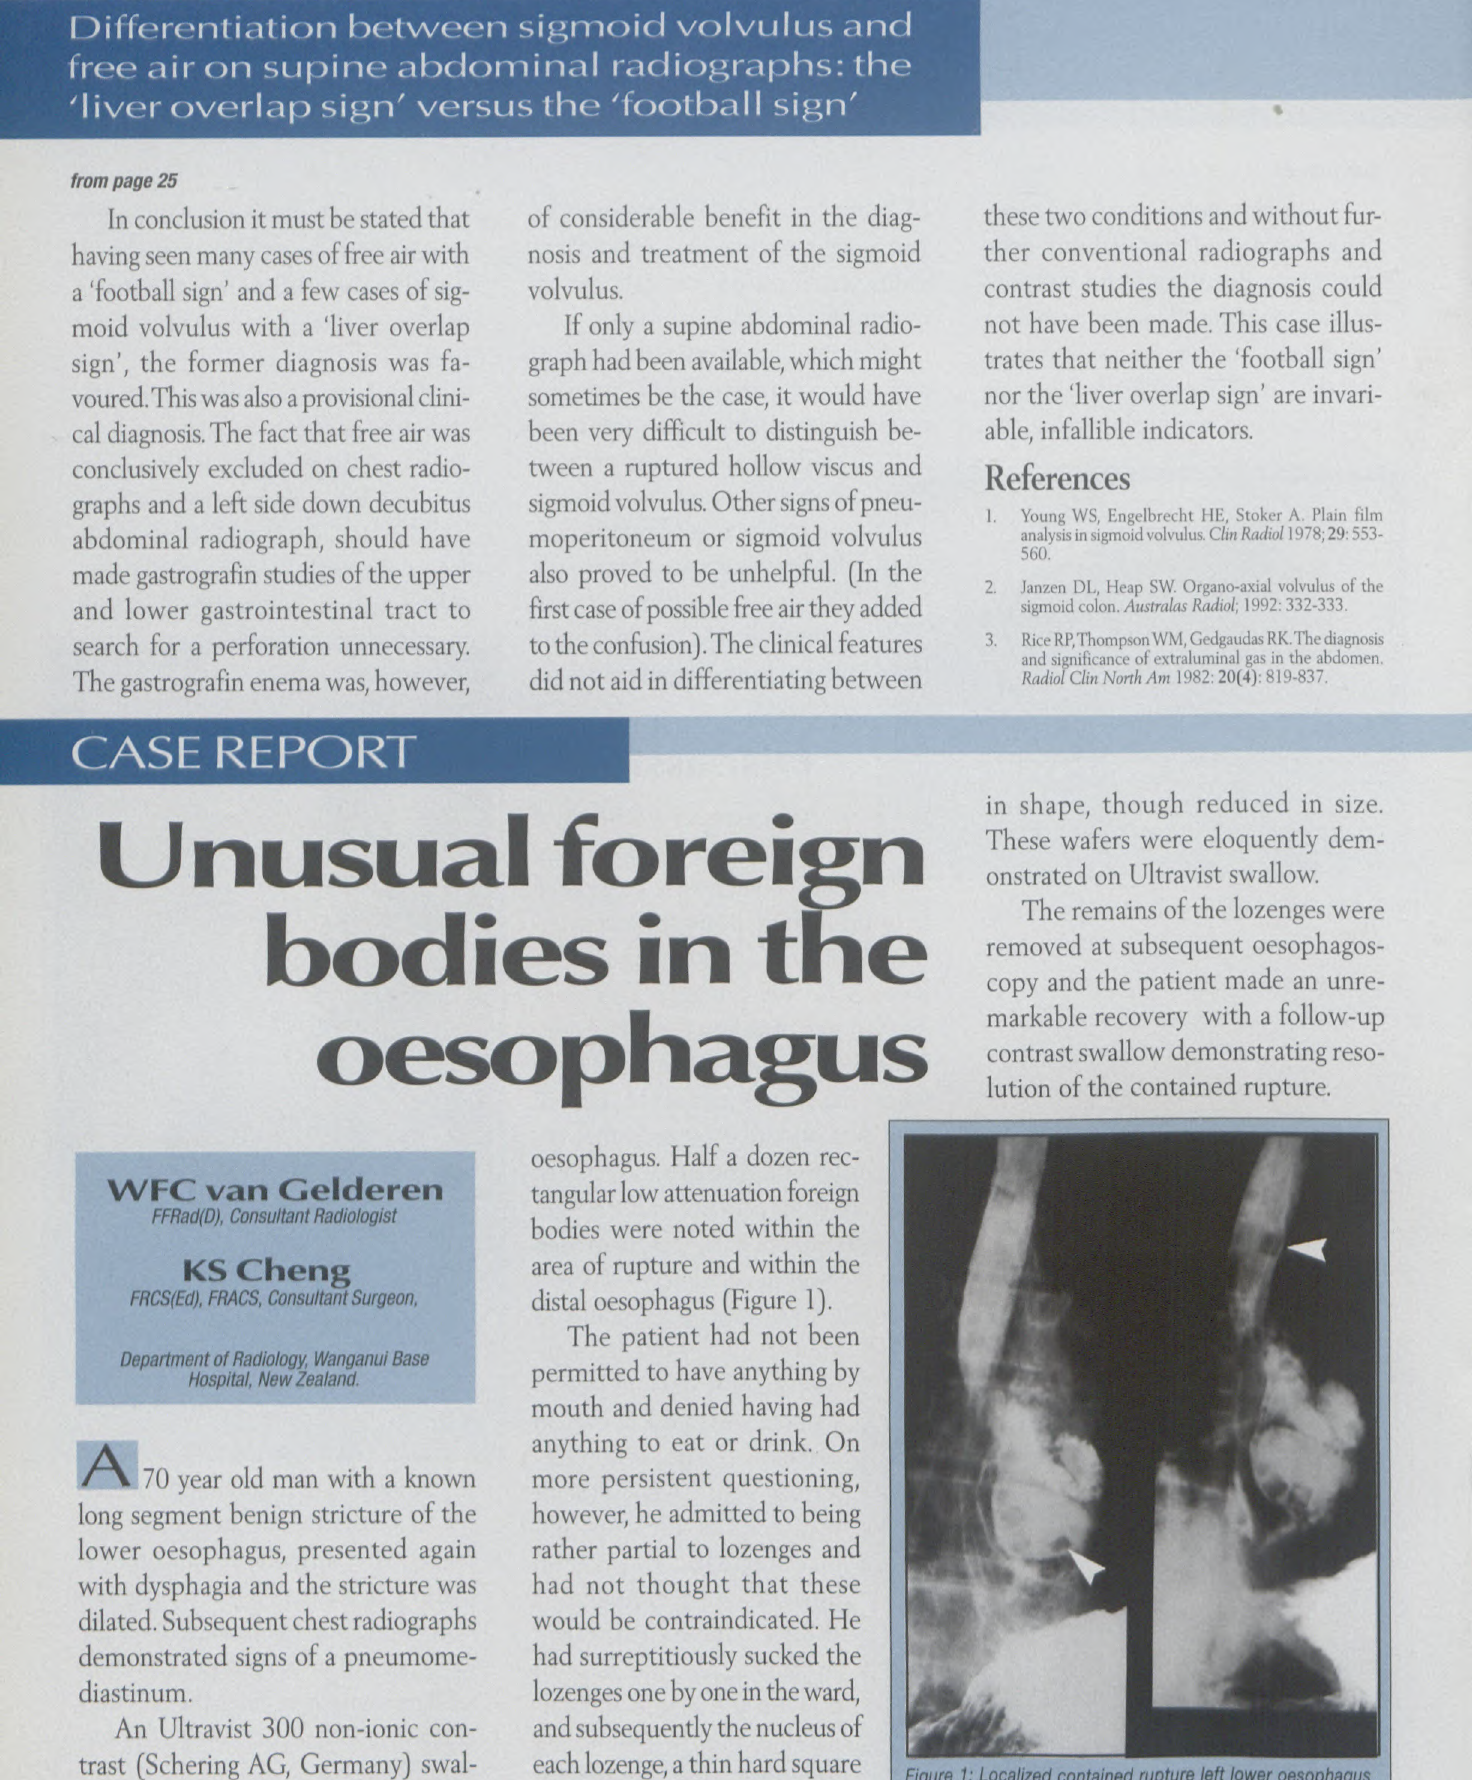
Figure 1: Localized contained rupture left lower oesophagus shown at contrast swallow. Note multiple rectangular low attenuation foreign bodies (arrows) which are the residue of lozenges sucked by the patient over the preceding